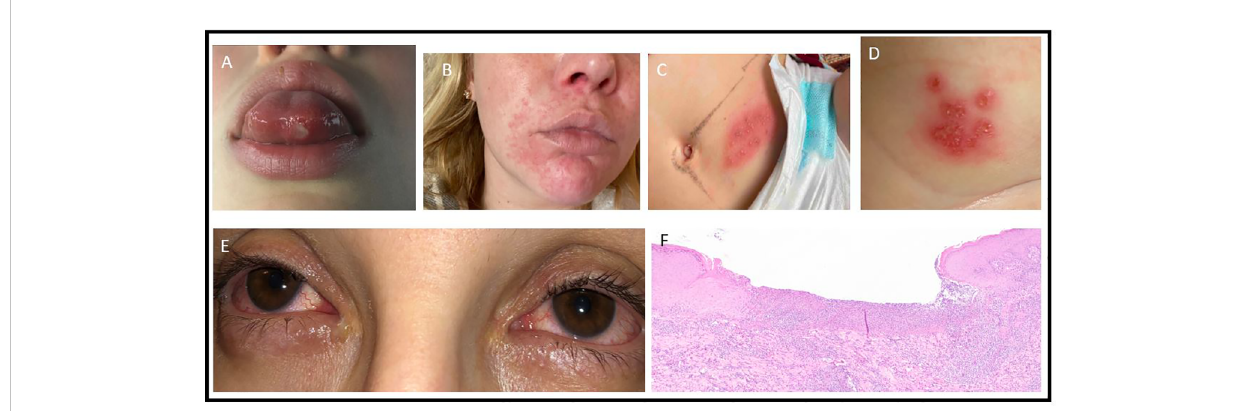
FIGURE 2 Clinical images. (A) : ulcer on tongue, F1-3B. (B) : facial rash, F1-3B. (C) : vesicular rash on lower abdomen, HSV negative, F4-4B. (D) : vesicular rash on inner thigh, F4-4B. (E) : conjunctivitis, F3-2B. (F) : Skin biopsy of F2-2G, showing an ulcerated lesion covered by fi brinoleukocytic exudate. The surrounding epidermis demonstrates discrete irregular epithelial hyperplasia. The dermis presents moderate lymphoplasmacytic and histiocytic in fi ltrate associated with neutrophilic